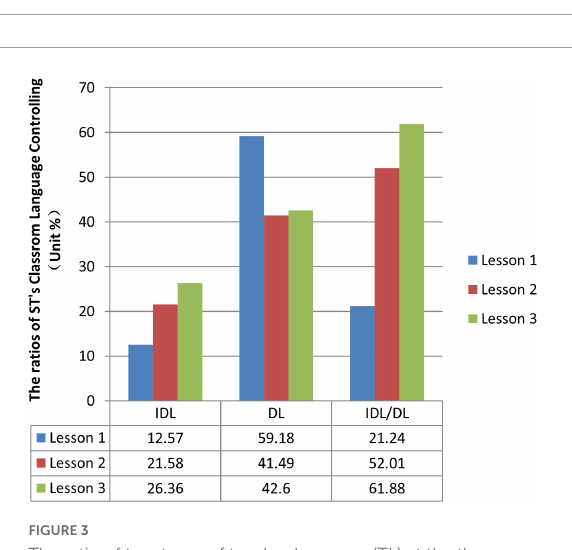
FIGURE3 The ratio of two types of teacher language (TL) at the three lessons.